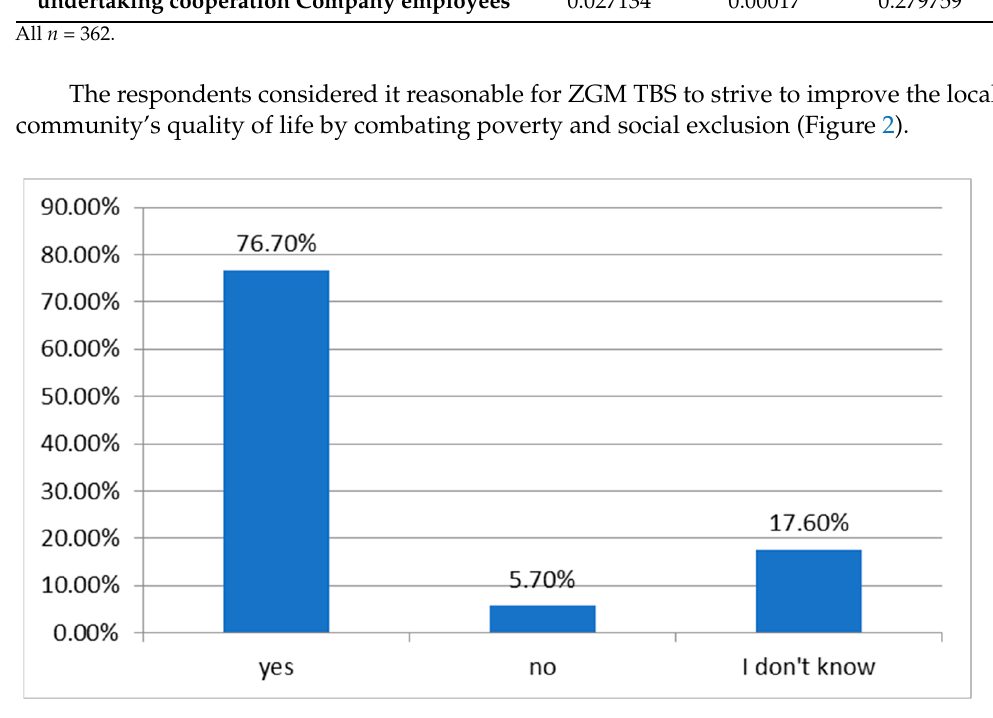
Figure 2. ZGM TBS Sp. z o.o. striving to improve the local community’s quality of life by combating housing poverty and social exclusion ( n = 362).